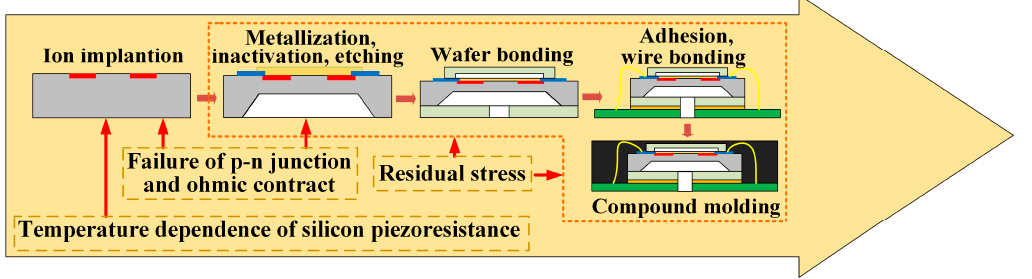
Figure 5. Possible instability of piezoresistive sensor in the main manufacturing processes.